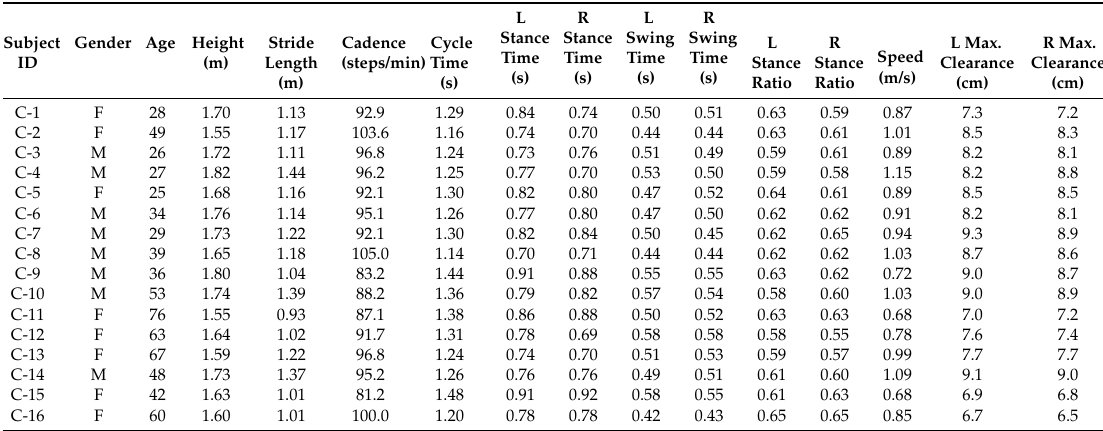
Table 3. Control subjects and extracted gait